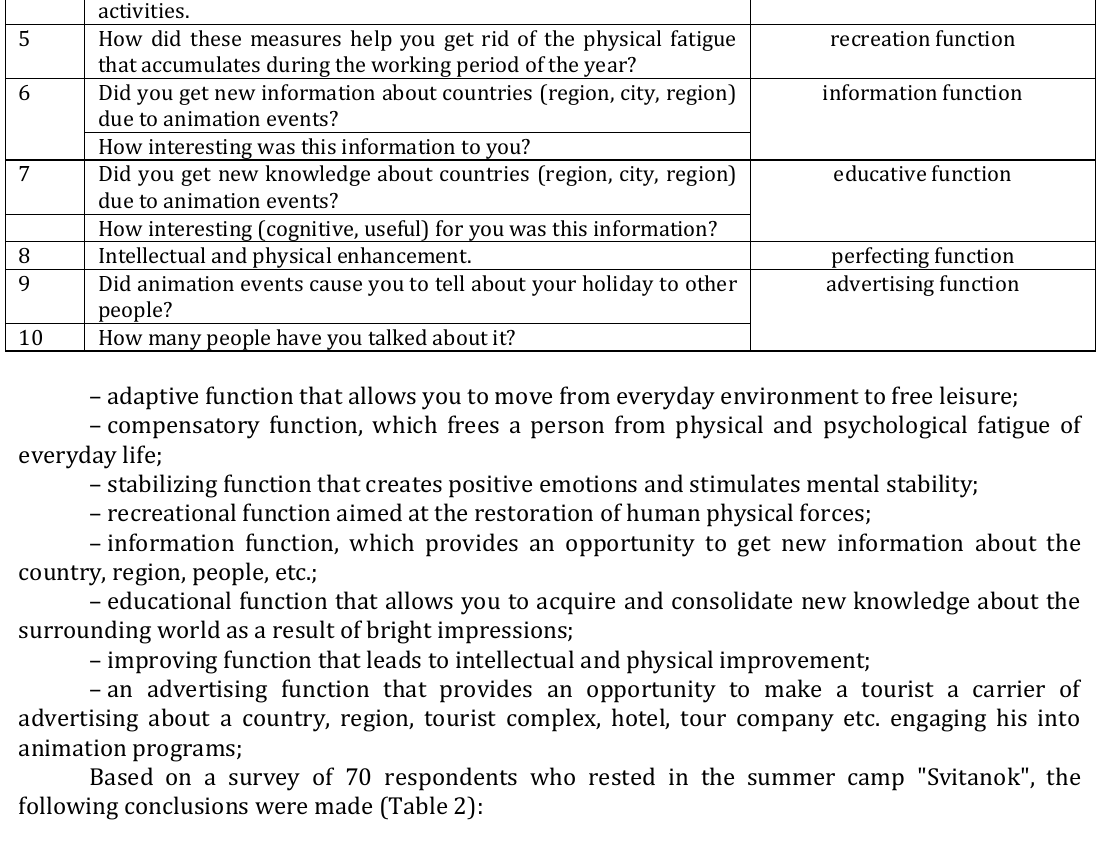
Table 2. Influence of animation activities accomplished in Svitanok Tour Complex (%) Scor